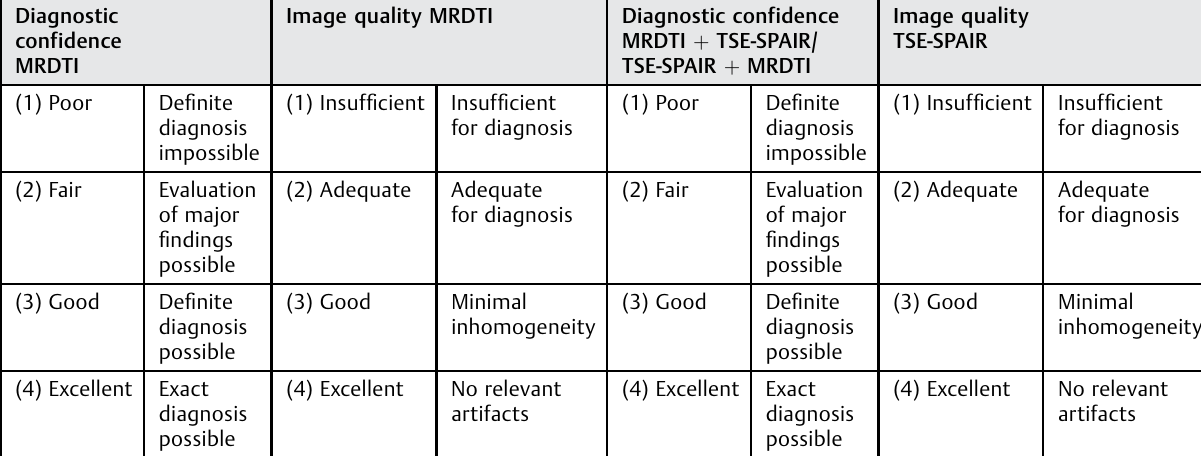
Table 1 Scoring for diagnostic con fi dence and image quality: 4-point Likert scale 20